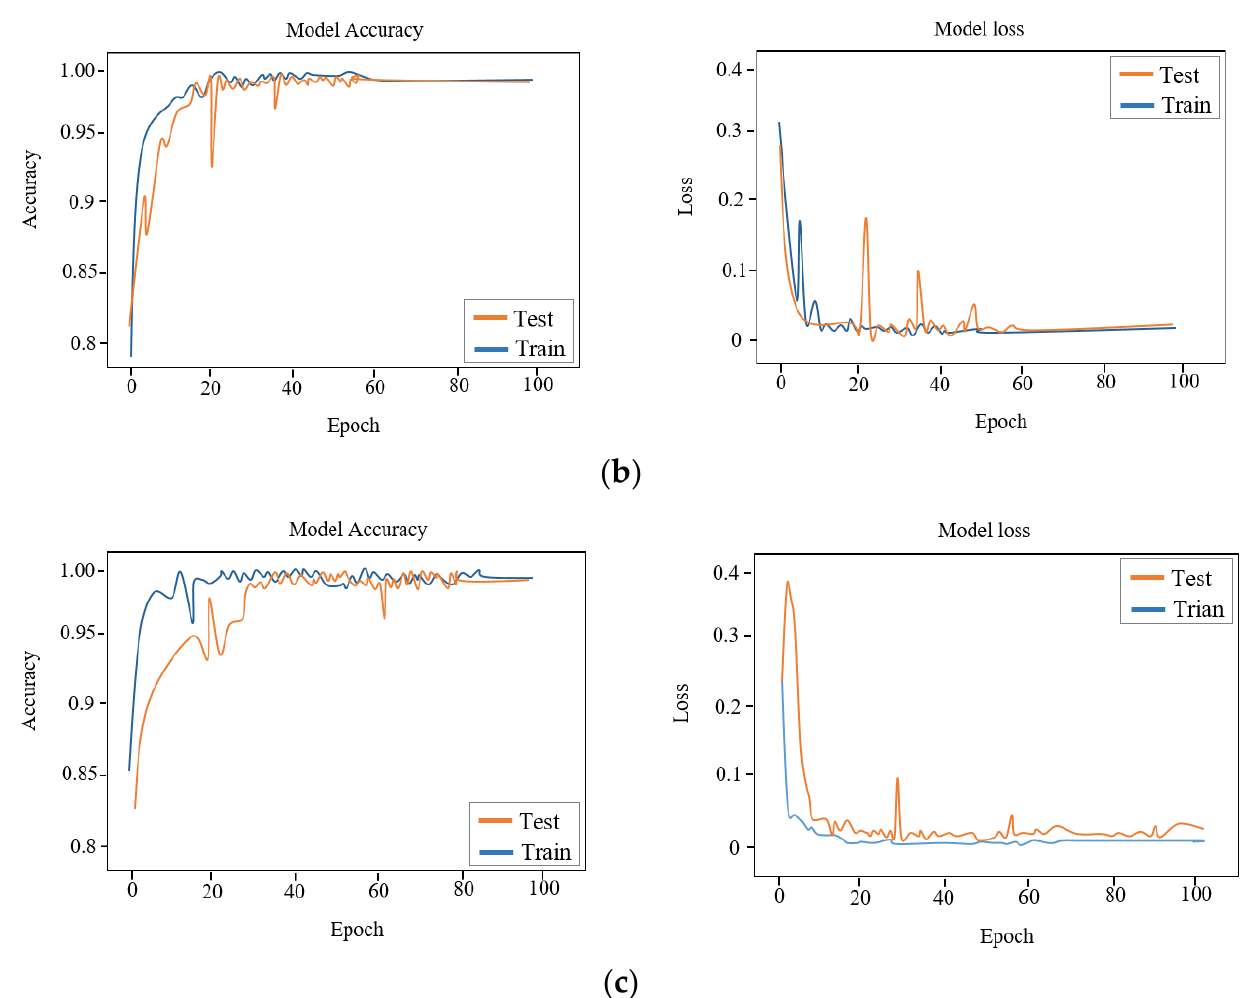
Figure 10. Accuracy and loss performance in the training and testing phases for the leaf image sizes of ( a ) 64 × 64, ( b ) 128 × 128, and ( c ) 256 × 256 pixels obtained through the proposed CNN model.